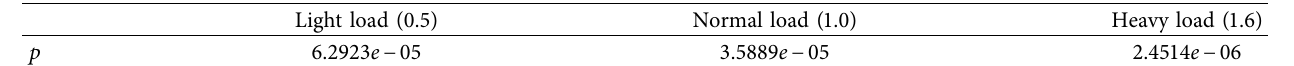
Table 10: Te Wilcoxon test probability for all the load variations.